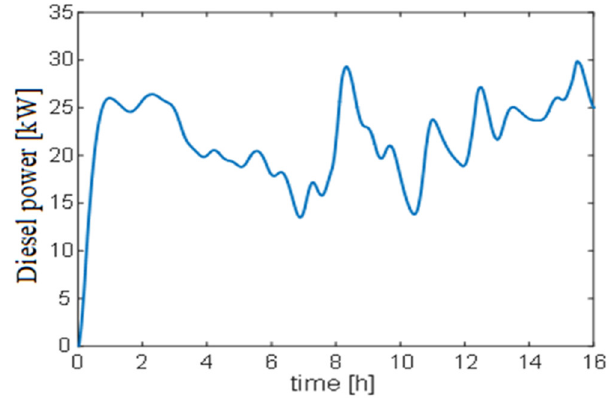
Figure 13. Power of the diesel generator at the point of coupling.